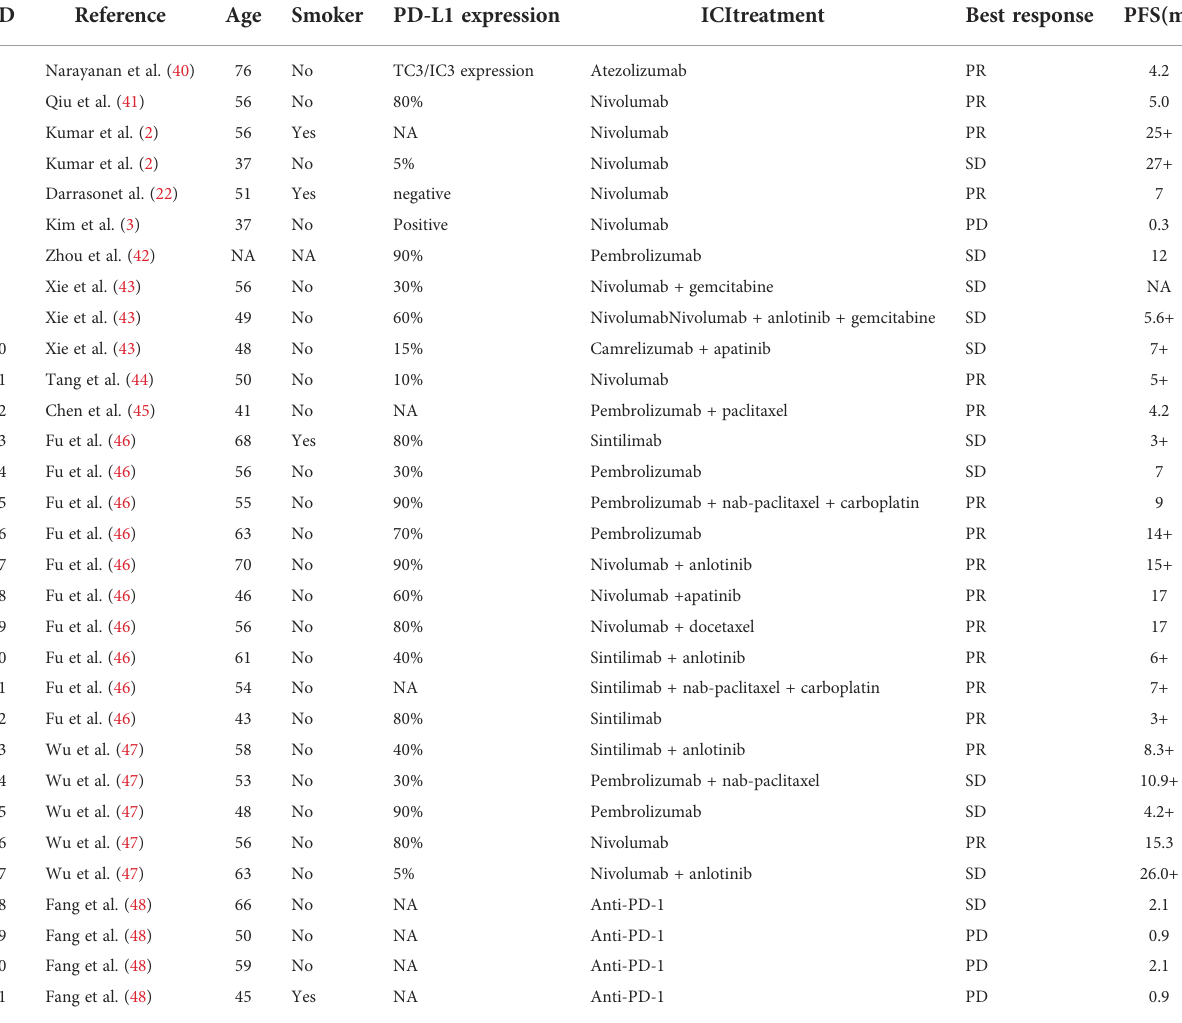
TABLE 3 Clinical characteristics of the 31 ICI-treated PLELC patients from previous